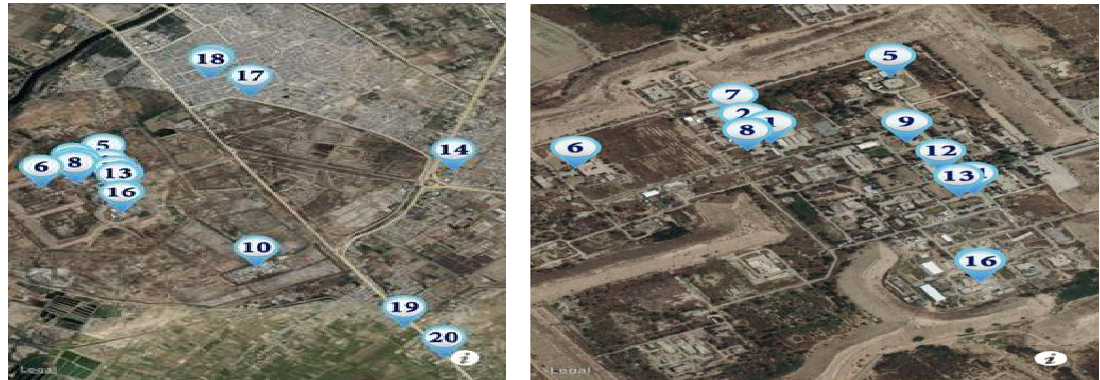
Fig.1: Aerial photo for Al-Tuwaitha nuclear site and the surrounding areas for studied